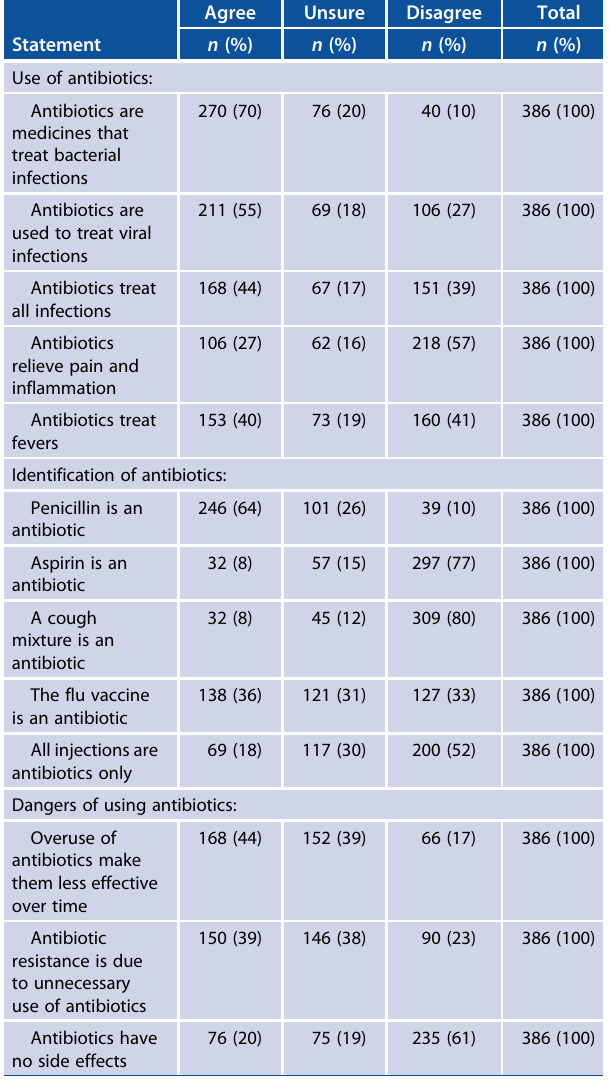
Table 2: Patients ’ knowledge of antibiotics at Prince Mshiyeni Memorial Hospital 2017